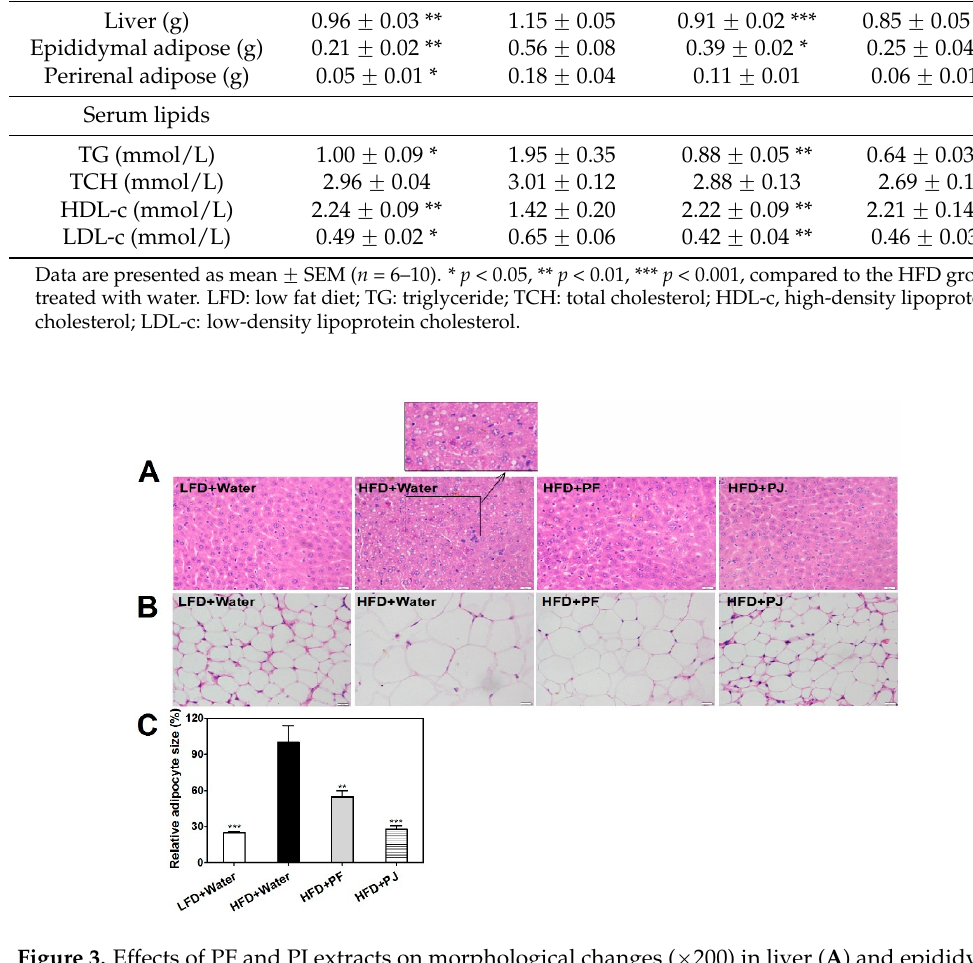
Table 3. Effects of PF and PJ extracts on weight of different tissues and serum lipids in high-fat diet (HFD) C57BL/6 mice.